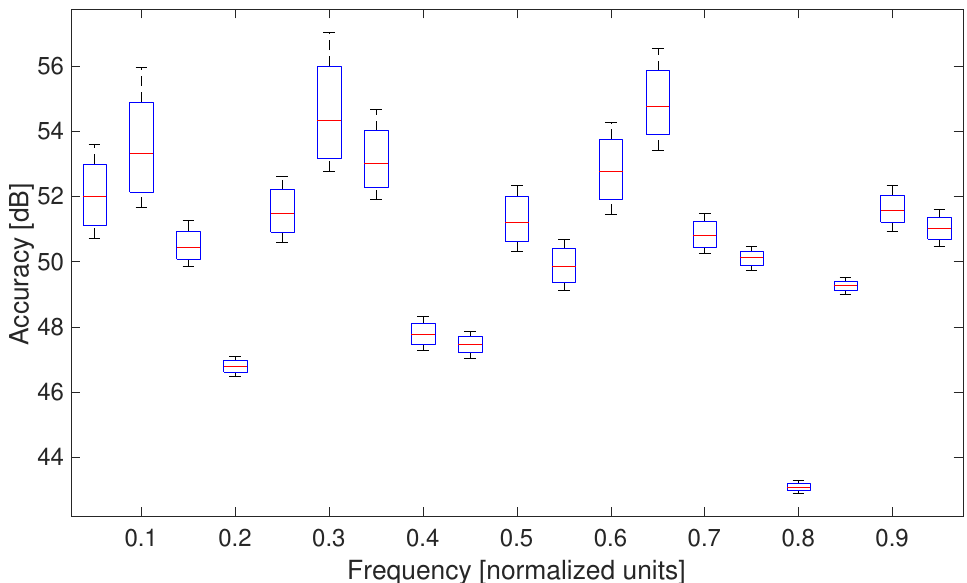
Figure 7. Boxplots for the KPI evaluated at normalized frequencies uniformly spaced by 0.05 units when the digital filters are characterized by length 2 L = 400.